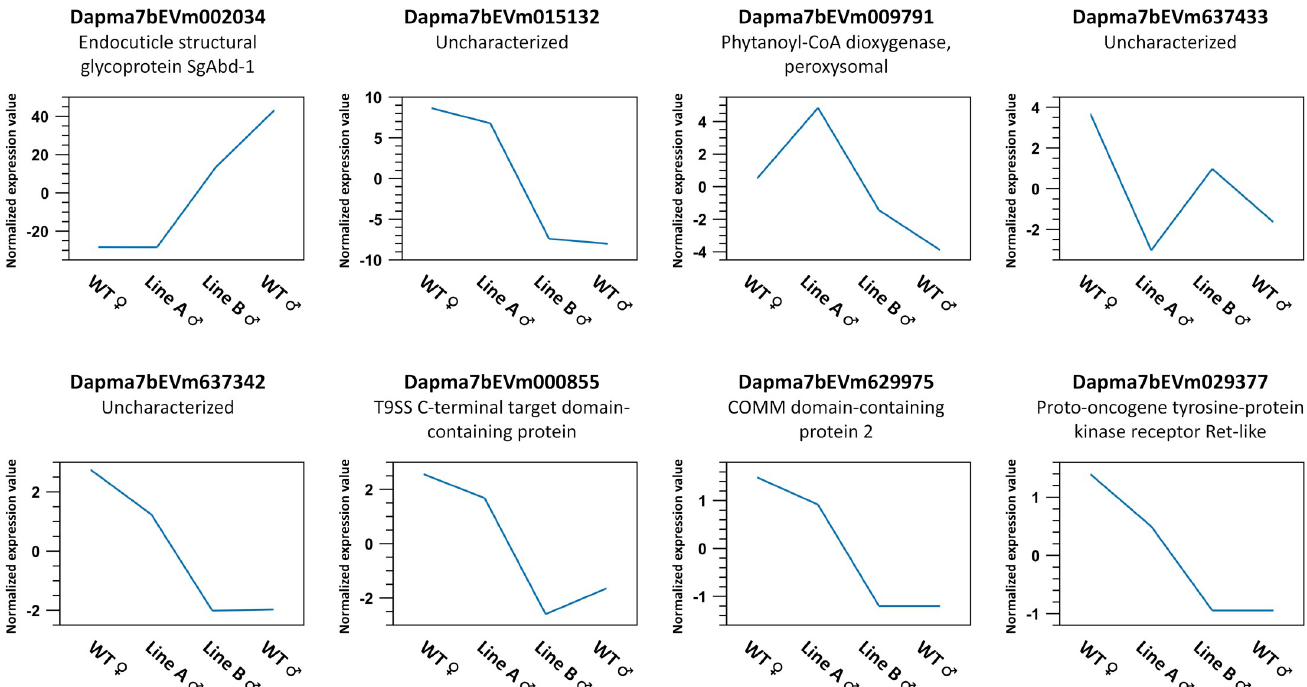
Fig 5. Eight genes showing differential expression between Line A male and Line B male. These genes were identified by applying a filter of p-value < 0.05, absolute fold change � 1.2 (EDGE test) in Line A male vs. Line B male comparison to the list of 731 sex-biased genes. Graphs have same meaning as those from K- medoids clustering in Fig